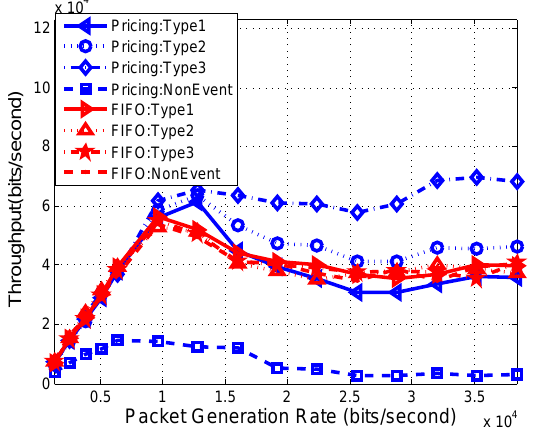
Figure 16. Throughput of different Event types for random topology.